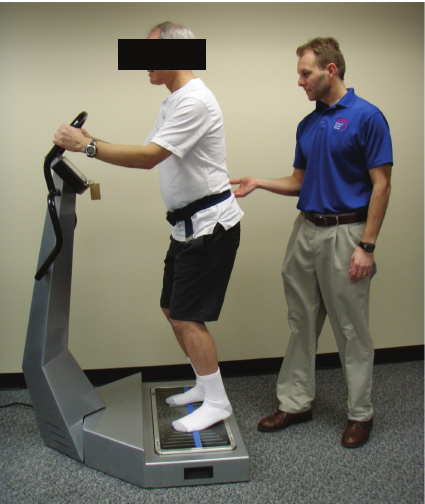
Figure 2: WBV setup. Subjects were exposed to 4 bouts of 30 seconds of WBV either at 2Hz or 26Hz interspersed with a 60- second rest break between bouts.